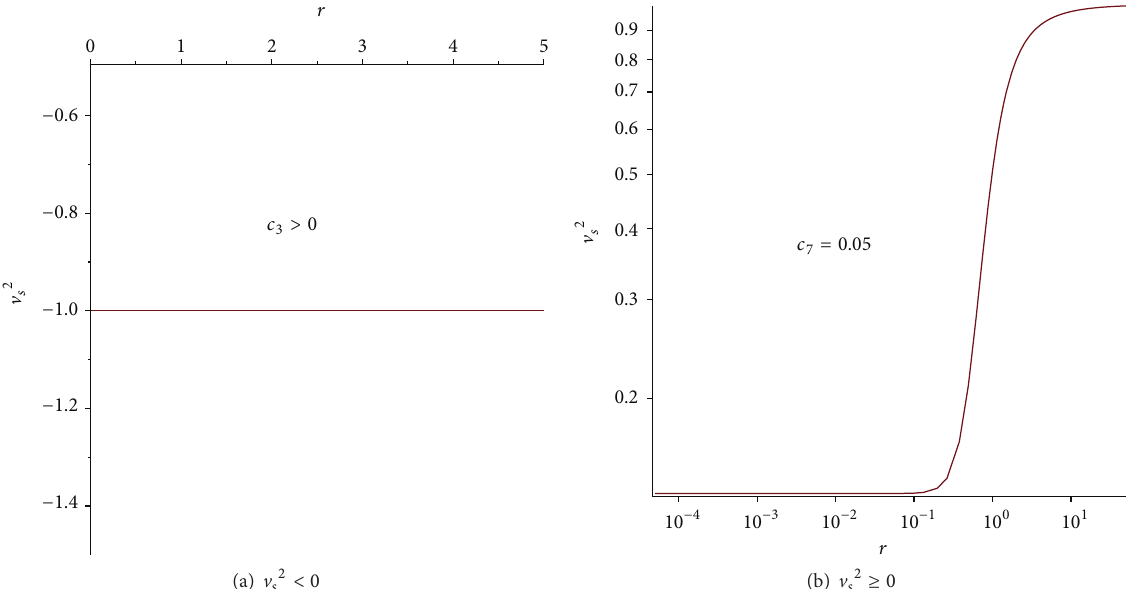
Figure 3: (a) shows that the first model does not have stability because the sound velocity V 𝑠2 ∉ [0, 1] as is required while (b) shows a stability behavior.